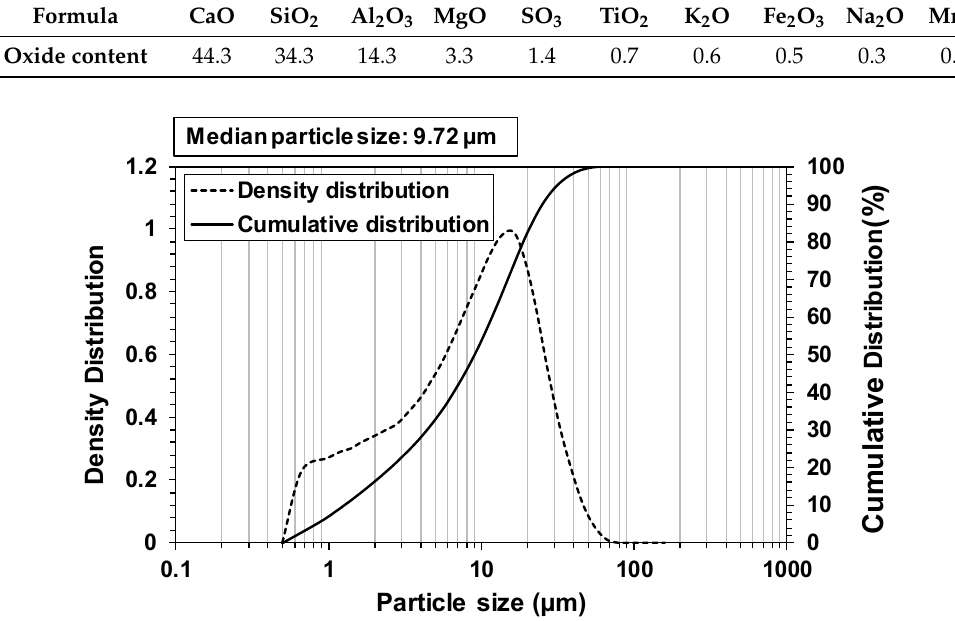
Figure 1. Particle size distribution of ground-granulated blast furnace slag (GGBFS).